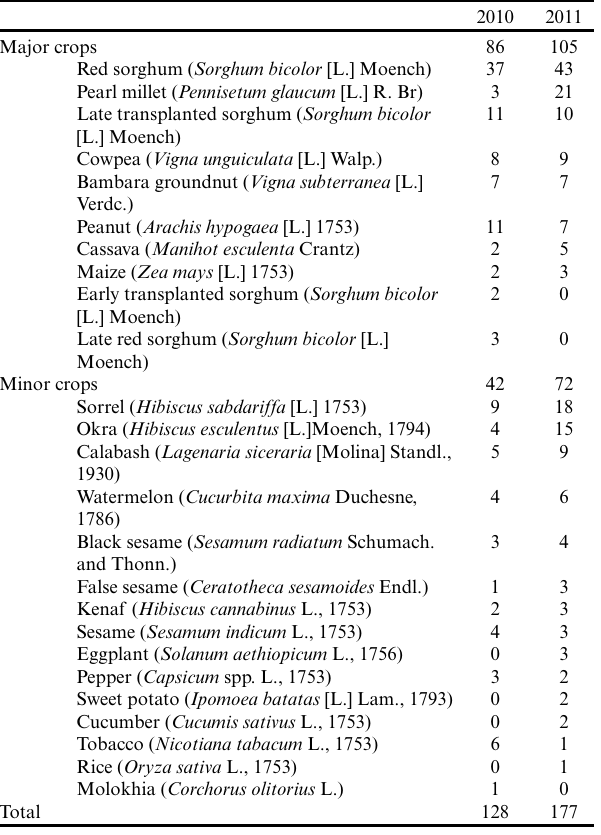
Table 2 . Seed acquisition events according to crop categories and species for 2010 and 2011.